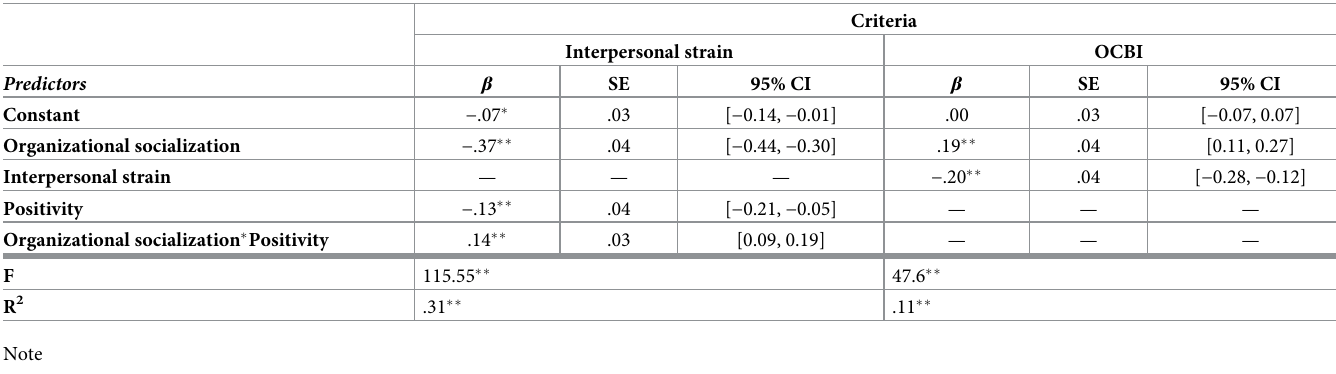
Table 2. Effects of the predictors on interpersonal strain and OCBI as